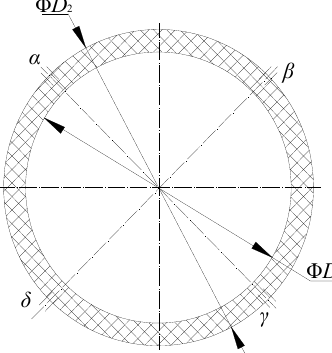
Figure 3 . Simplified single-tube calculation capacitor. Figure 3. Simplified single-tube calculation